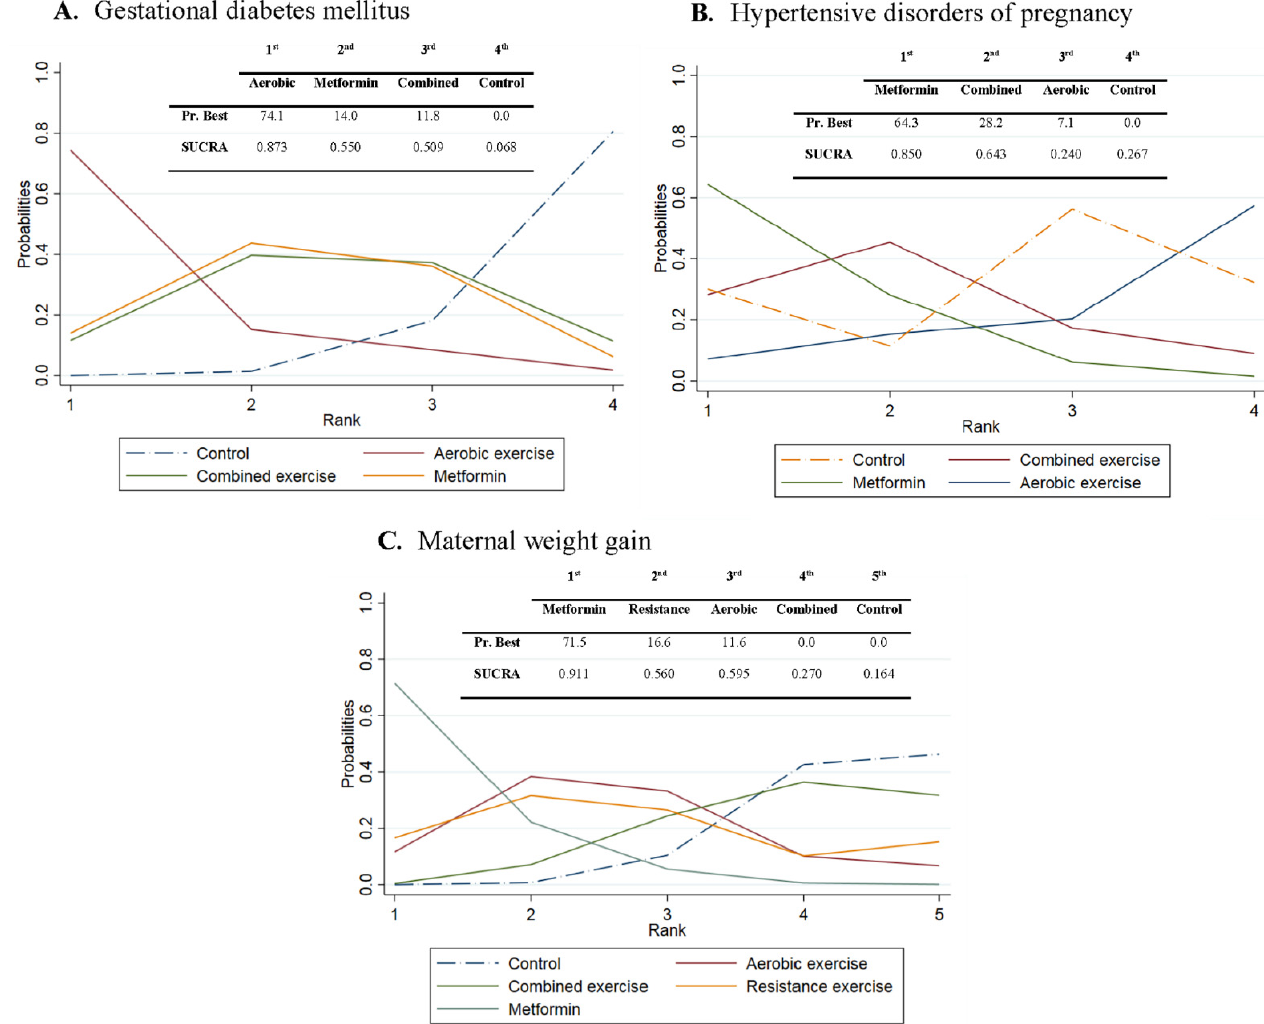
Figure 3. Relative rankings of treatments for gestational diabetes mellitus ( A ), hypertensive disorders of pregnancy ( B ) and maternal weight gain ( C ). Graphs of the rankograms for each outcome. In each graph, the data of each intervention were detailed in a table for the probability of being the best intervention (Pr. Best) and its SUCRA.